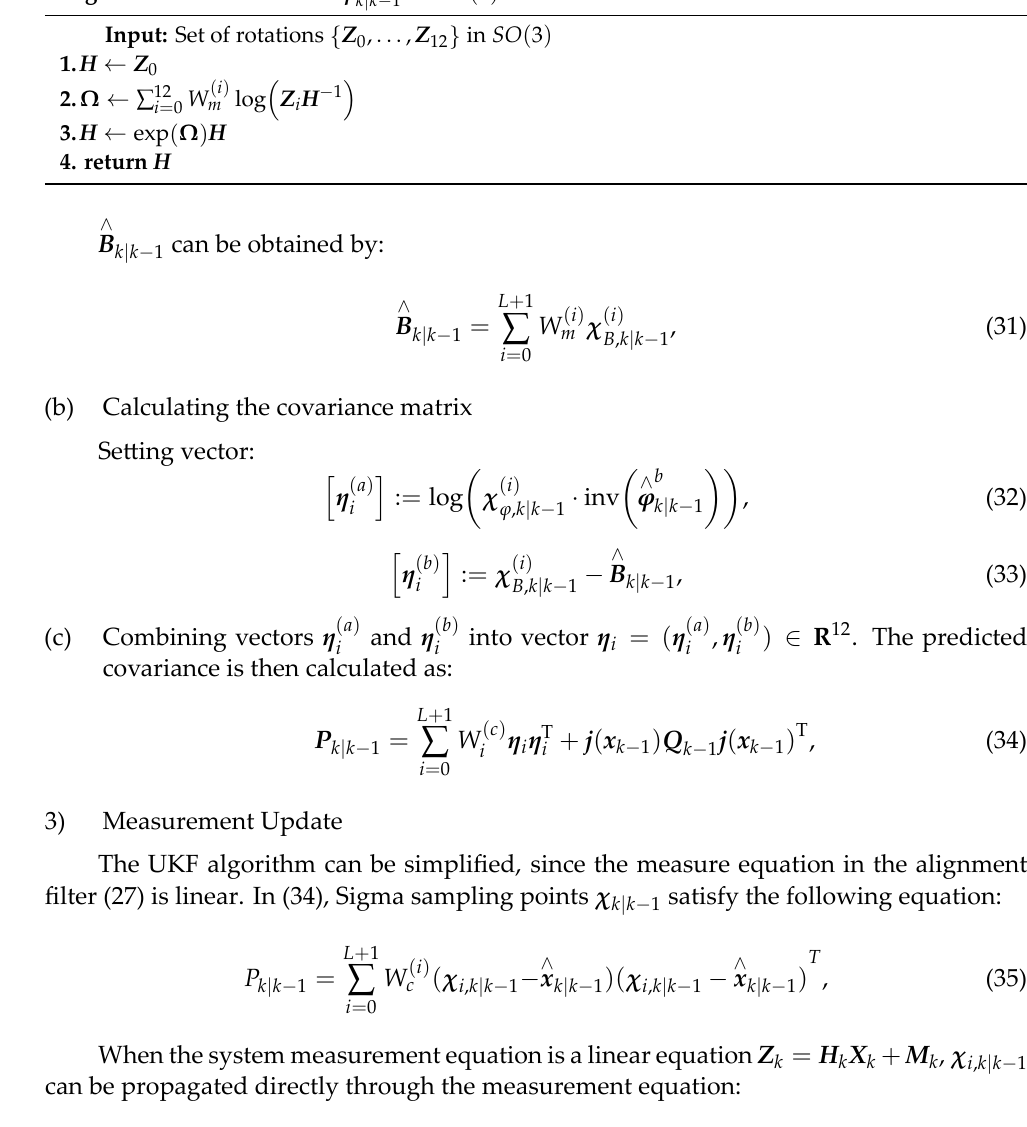
b ∧ φ on SO ( 3 ) k | k − 1